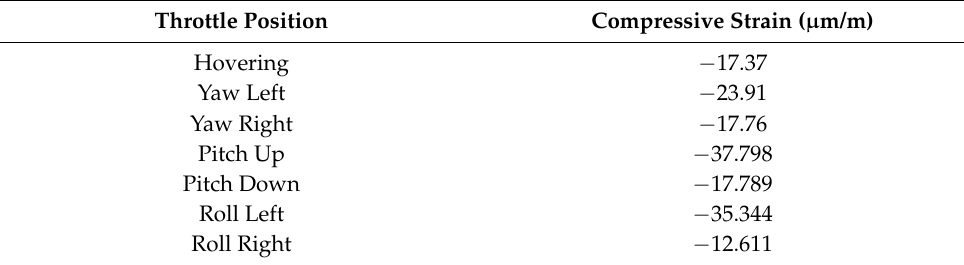
Table 12. Strain induced during hovering, yaw, pitch and